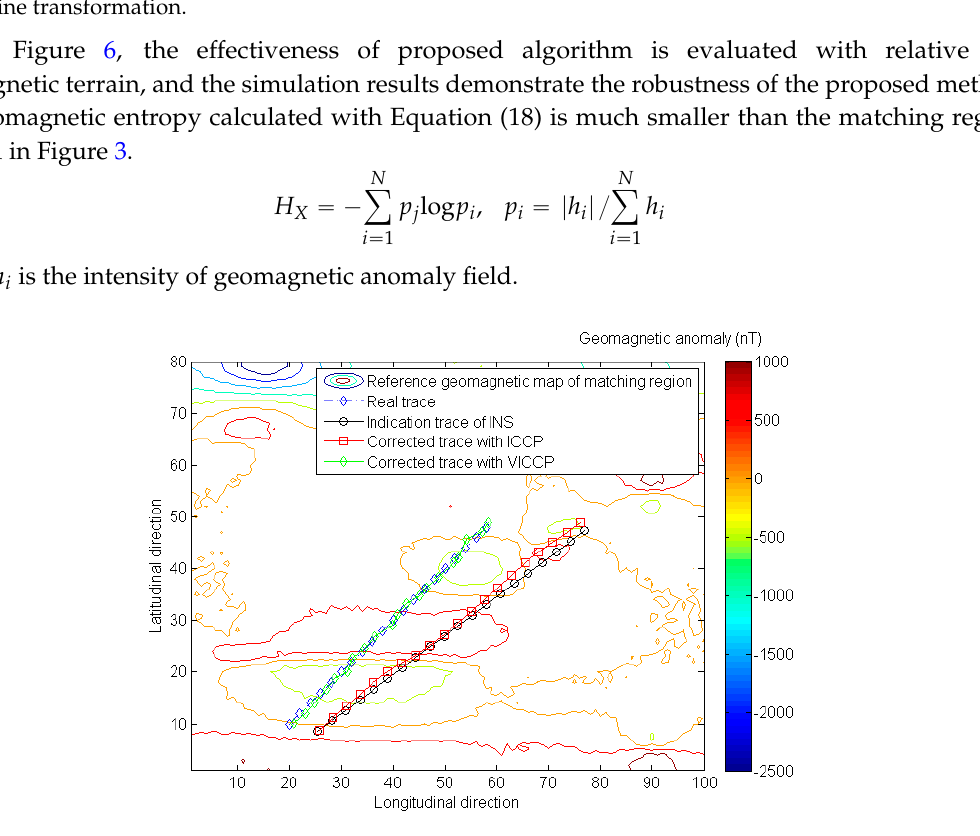
Figure 5. The comparison of geomagnetic matching results for VICCP with rigid transformation and affine transformation. Table 4. Comparison of VICCP with different transformation for 100 times Monte Carlo